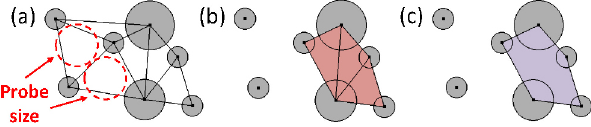
Fig. 7 Relationship between: (a) dual triangulation, (b) α -complex, (c) α